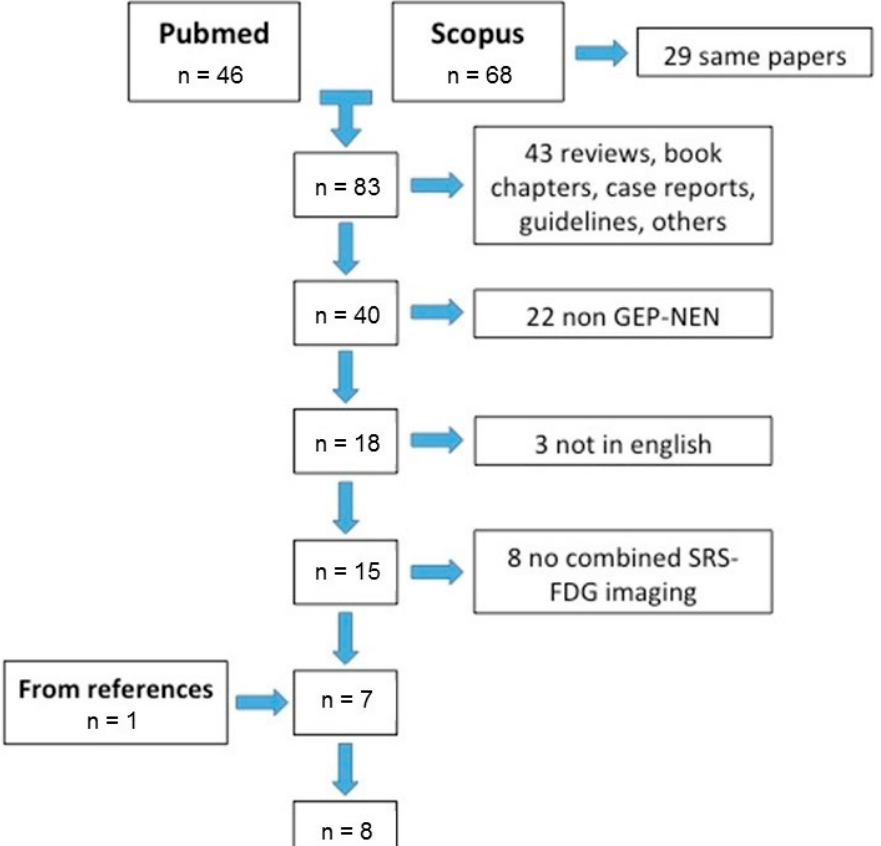
Figure 1. Flowchart of included papers.